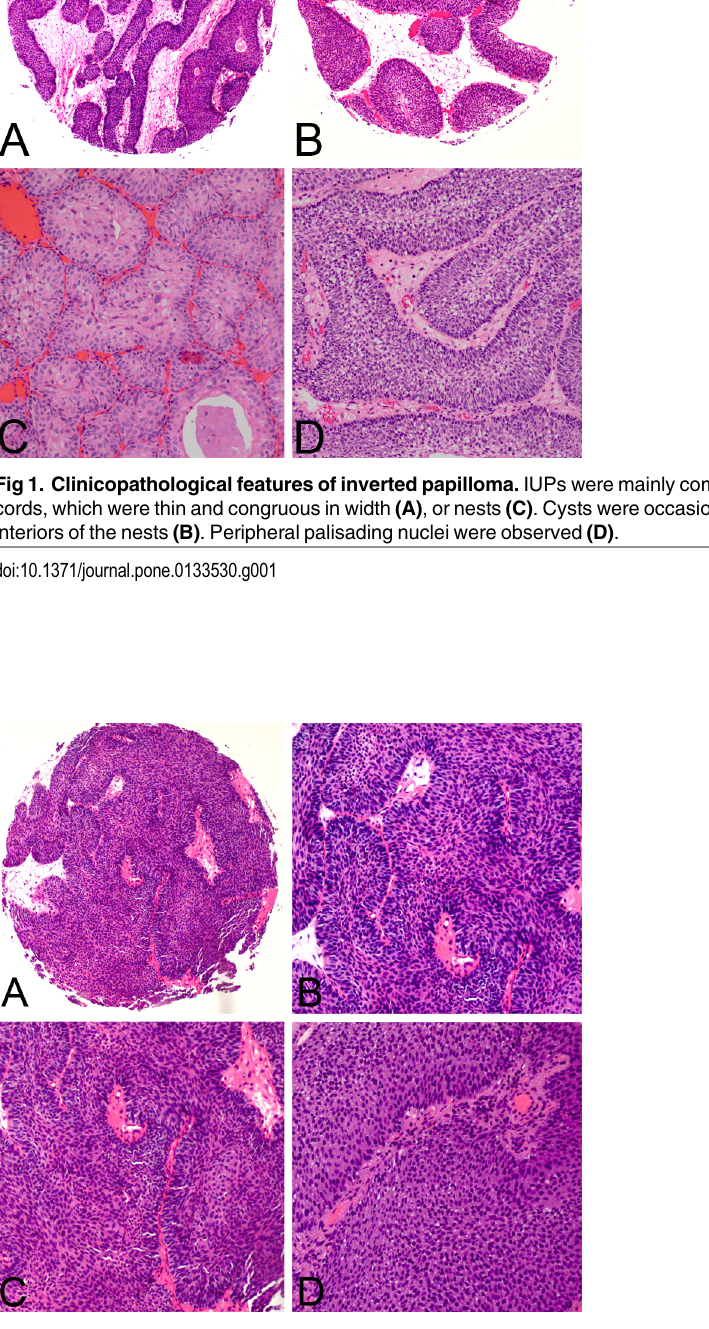
Fig 2. Clinicopathological features of low-grade noninvasive UC with an inverted growth pattern. The cords of LGNUC with an inverted growth pattern were usually thick and irregular (A), and definite fibrovascular cores were observed (B). Nests were usually large and inordinate (C), and mitotic figures, which were common in the superficial or middle layers, were easy to detect (D).